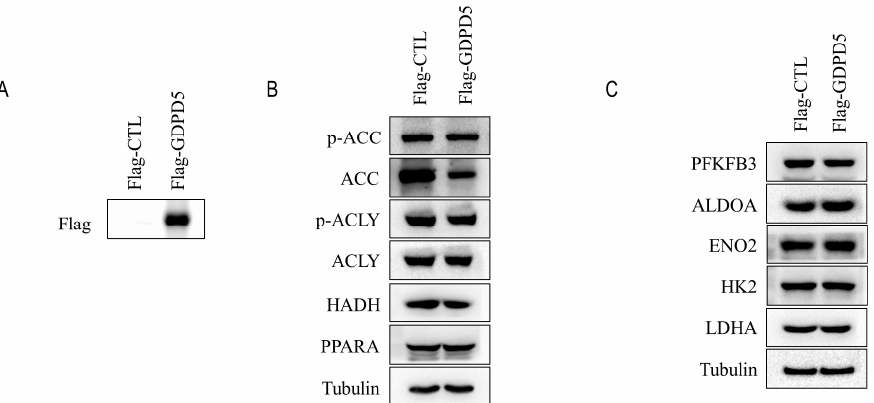
Figure 7. GDPD5 affects the migration and proliferation of human neuroblastoma cell line SH-SY5Y. ( A,B ) GDPD5 effects inhibit the migration ( A , B ) proliferation of SH-SY5Y. *:P<0.05, ***:P<0.001. 3. Discussion According to the Children’s Oncology Group (COG) risk stratification, neuroblas- toma (NB) can be divided into three grades: low, intermediate and high [34]. The five-year survival rate for low- and intermediate-risk patients is higher than 90%, while the long- term survival rate for high-risk patients is less than 50%, even after multiple approaches [35]. Therefore, it is necessary to explore new prognostic indicators to improve the prog- nosis of high-risk NB patients. The arrival of second-generation sequencing technology and the era of big data have provided new ideas for the prognosis evaluation of NB pa- tients. Risk profiles related to MYCN [36,37], immunity [38] and glycosyltransferases are emerging [39]. Numerous studies have shown that lipid metabolism is related to cancer progression, metastasis and treatment and has the potential to become a new biomarker [40–42]. Risk scores of lipid-metabolism-related genes have been constructed to predict the survival rate of colon adenocarcinoma [43], lung adenocarcinoma [44], bladder cancer